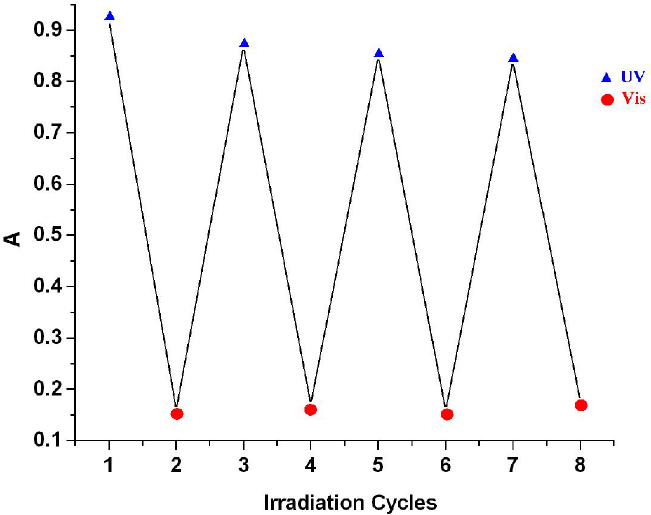
Figure 4. UV-Vis switch cycles of ABM 2 in DMF solution upon alternate irradiation with the UV/blue